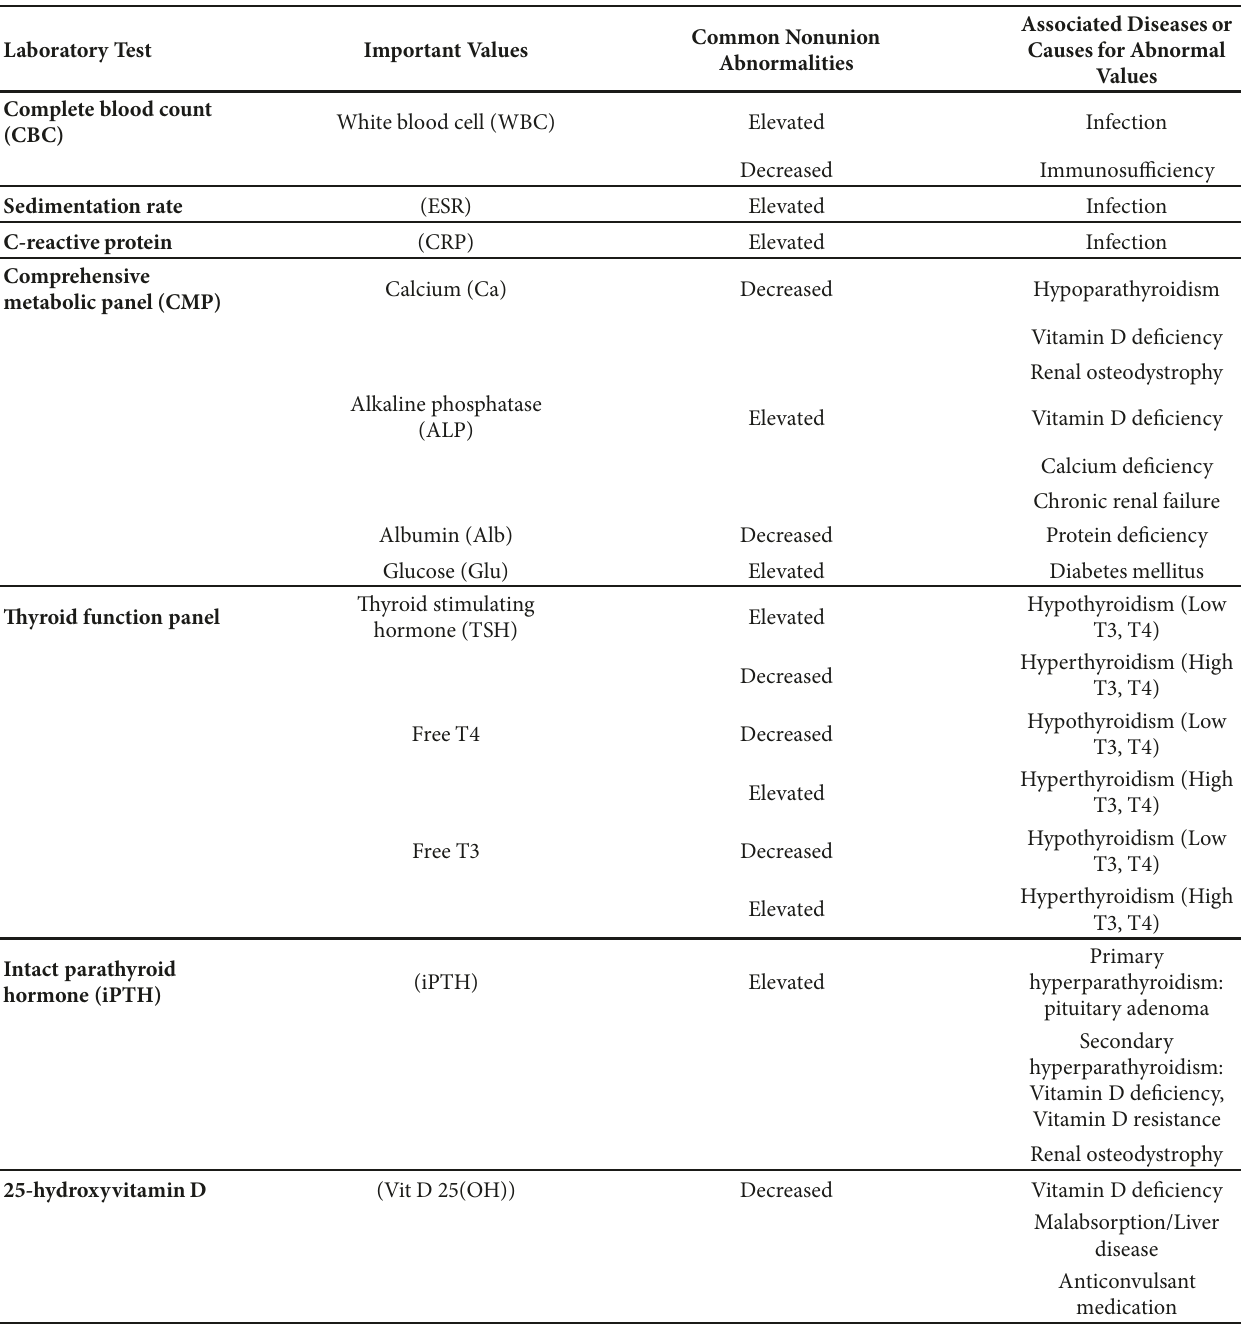
Table 1: Recommendation for initial metabolic laboratory evaluation in the setting of fracture nonunion, with associated common abnormalities and underlying disease processes. We recommend CBC, CMP, 25-hydroxyvitamin D, iPTH, and TSH, as well as CRP and ESR to rule out infection. Additional tests may be required and obtained by a treating endocrinologist depending on the initial laboratory screening